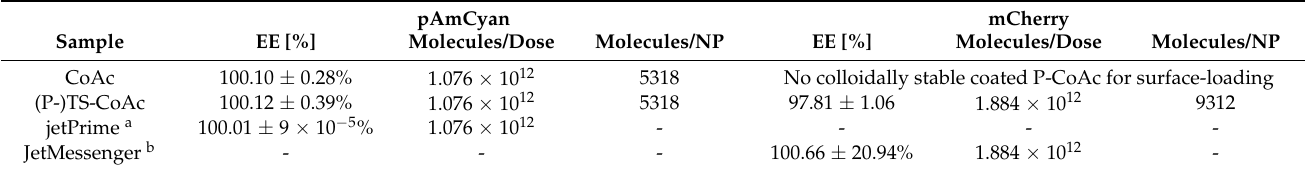
a,b For the transfection reagents JetPrime and JetMessenger, the particle count was not available to calculate the number of NA